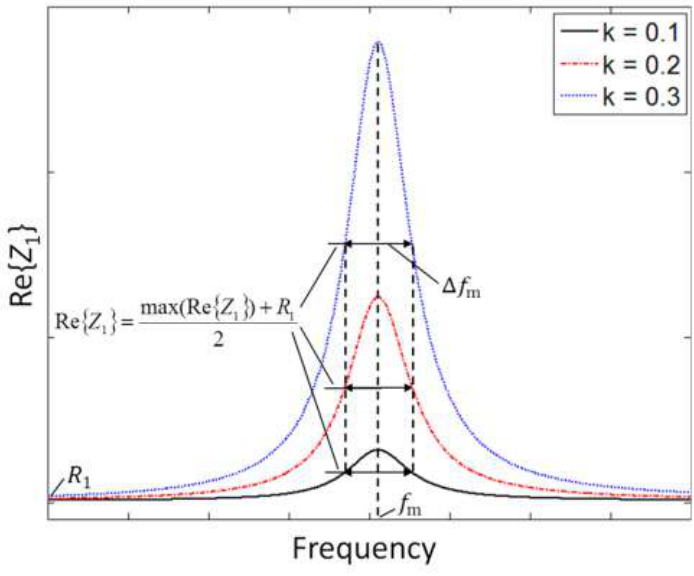
Figure 4. Real part of Z 1 as a function of frequency from Equation (4) for three different values of k .